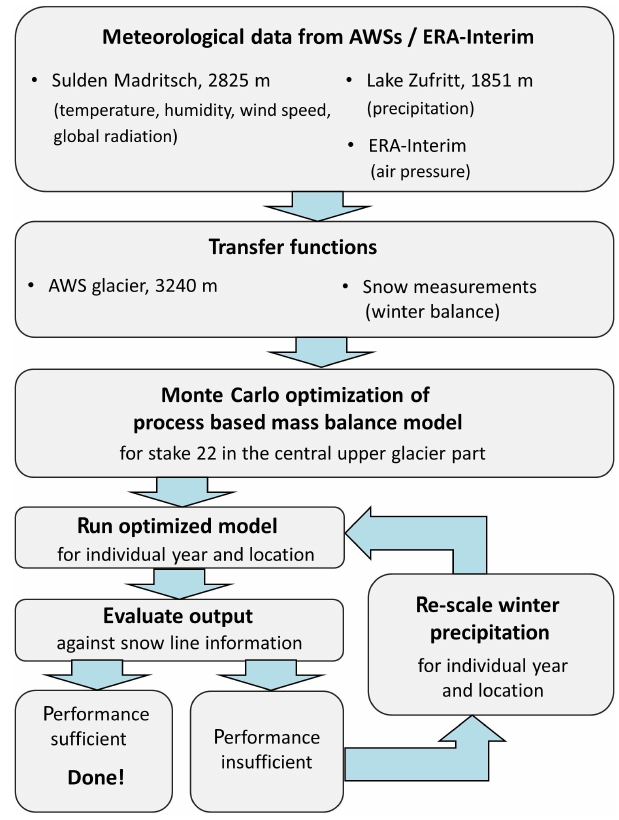
Figure 3. Schematic flow-chart illustrating the applied model ap-